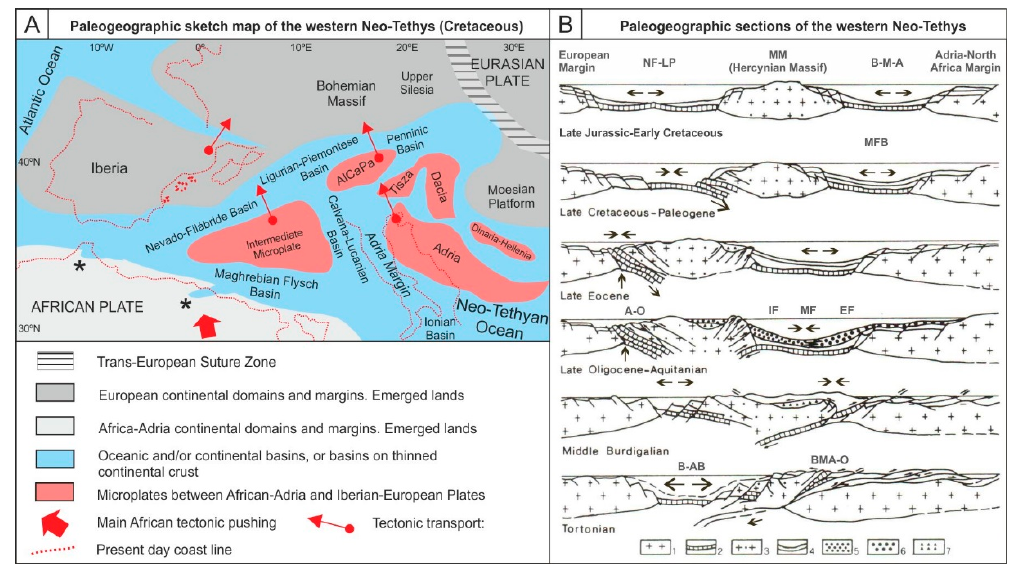
Figure 6. Simplified paleogeographic sketch map in the late Jurassic-early Cretaceous representing the main features and domains of the central-western Mediterranean Tethyan area (Box A ); seven synthetic sections showing the main crustal elements (oceans, continents and sedimentary covers), subduction zones, main tectonic movements and orogenic phases representative of the evolution of eo-alpine and neo-alpine systems (Box B ) are also shown. Key: NF-LP, Nevado Filabride-Ligurian Piemontese Basins; B-M-A, Betic-Maghrebian-Apennines; MFB, Maghrebian Flysch Basin; IF , Internal Flysch (MFB); MF , Mixed Flysch (MFB); EF , External Flysch (MFB); B-AB, Back-Arc basins; BMA-O, Betic Maghrebian Apennine orogen; 1 , Continental crust of the European and African margins; 2 , Oceanic crust; 3 , Continental crust of the Mesomediterranean Microplate (MM); 4 , Meso-Cenozoic sedimentation; 5 , Syn-orogenic flysch deposits (MFB); 6 , Numidian deposits (MFB); 7 , Late-orogenic flysch deposits.